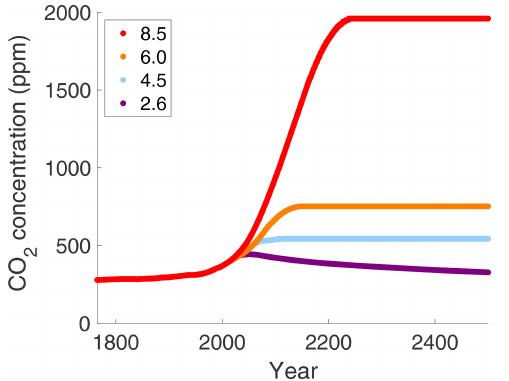
Figure 4. Carbon dioxide concentration µ , as projected by the IPCC for each of the four RCP hypothetical scenarios. This figure is gen- erated from data at IIASA (2019).